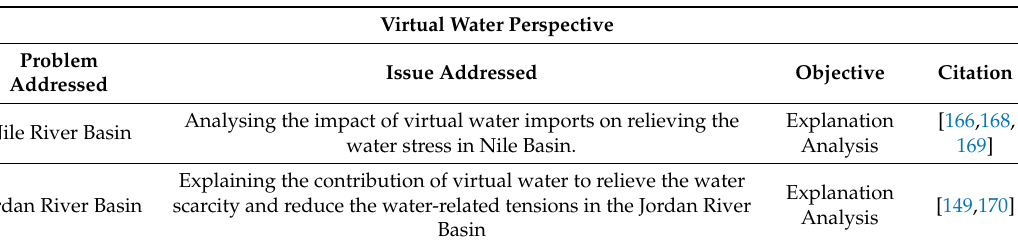
Table 8. Virtual Water Mechanism—Theory and Implementation.